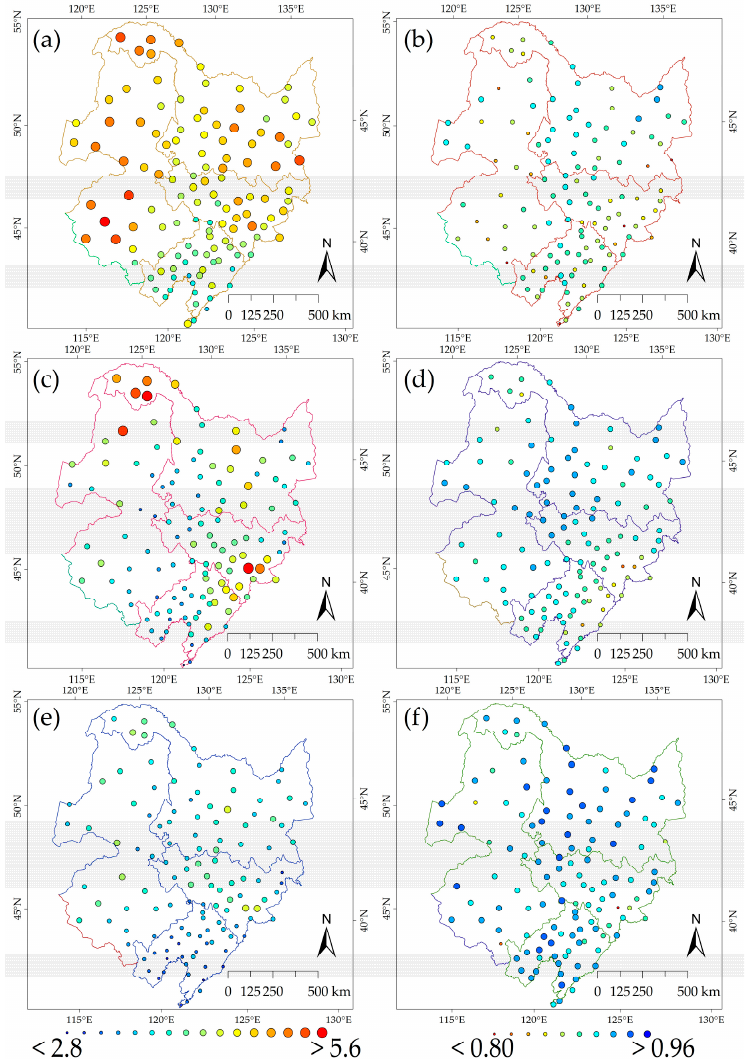
Figure 7. ( a – f ) Spatial distribution of the optimal models RMSE: ( a ) T max , ( c ) T min , ( e ) T mean and MEF: ( b ) T max , ( d ) T min , ( f ) T mean for all the meteorological stations.